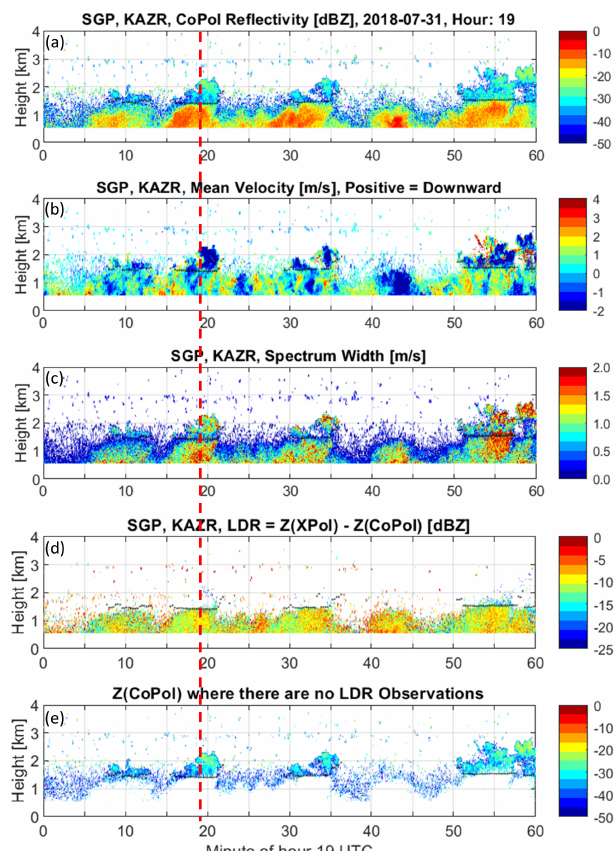
Figure 2. Moments calculated from raw spectra for hour 19:00UTC on 31 July 2018. (a) CoPol reflectivity (dBZ). (b) Mean radial velocity (ms − 1 ); positive values are downward motion. (c) Spec- trum width (ms − 1 ). (d) Linear depolarization ratio (LDR) (dB). (e) CoPol reflectivity (dBZ) at pixels that do not have an LDR mea- surement. The black symbols in all panels are ceilometer-derived cloud base. The vertical dashed line indicates time 19:02UTC, which is the time of the profile shown Figs. 3 and